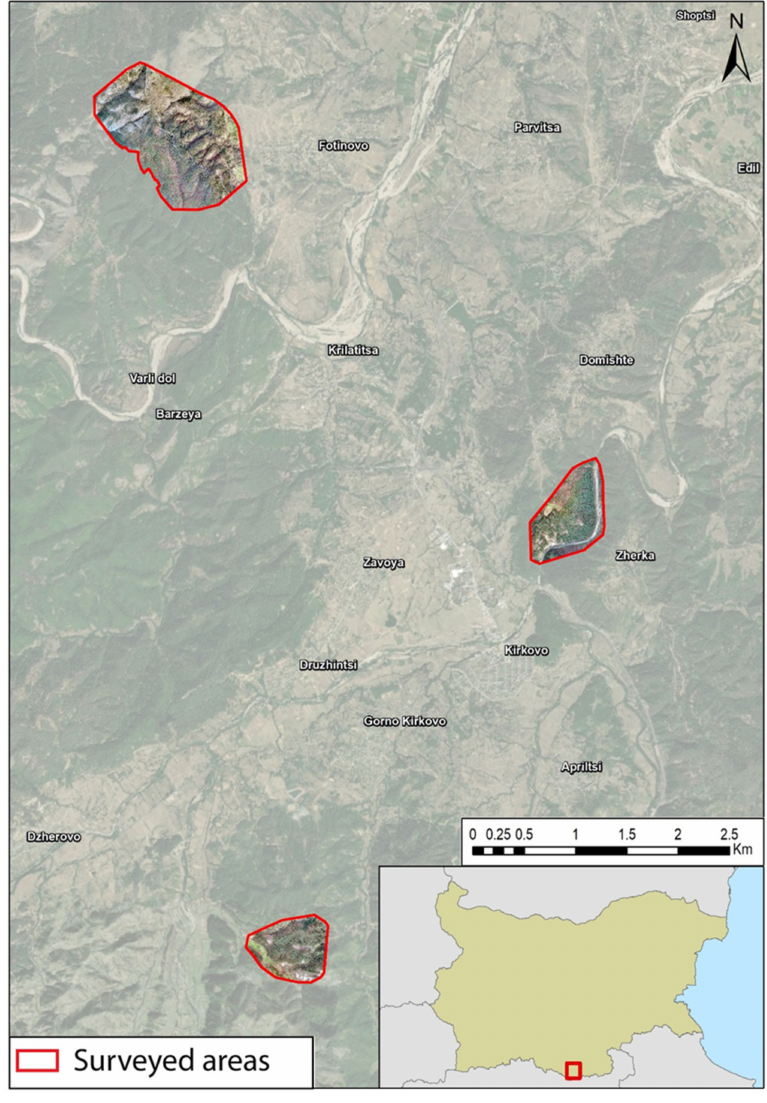
Figure 1. Map of surveyed